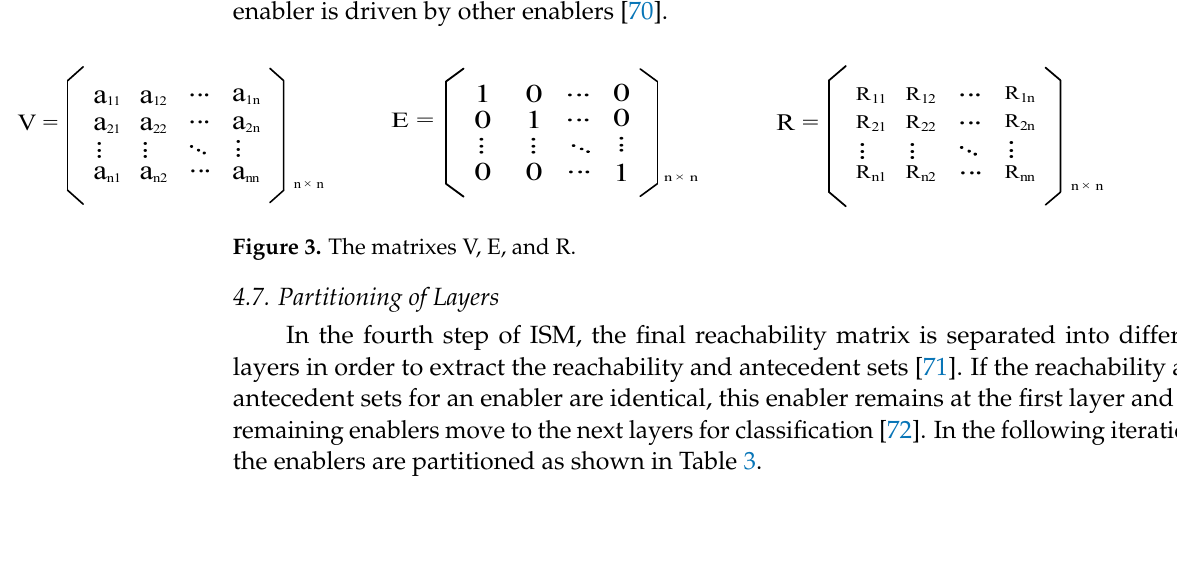
Table 3. Layer partition of reachability matrix of enablers.